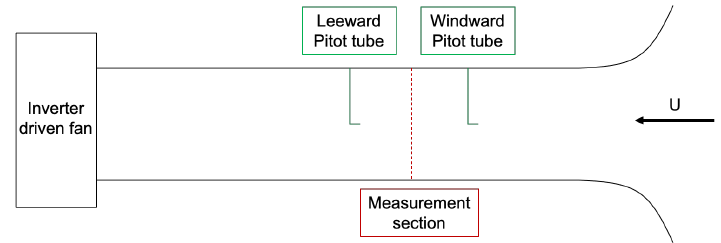
Figure 2. Experimental setup to measure the pressure loss coefficient.